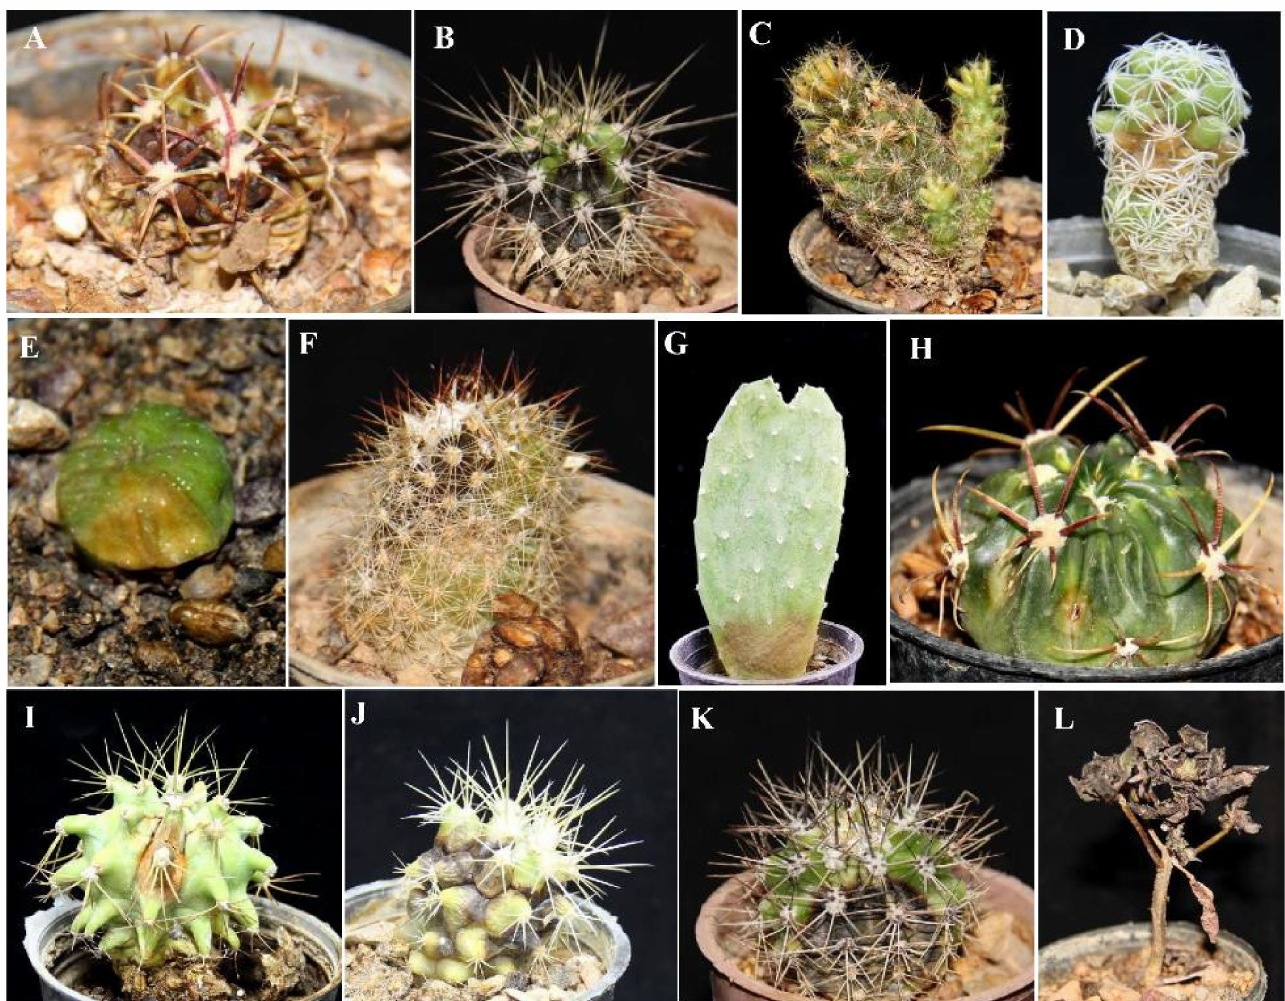
Figure 4. Symptoms induced by artificial inoculation of Neocosmospora falciformis on various succulent plants. ( A ) Crown rot on Ferocactus macrodiscus ; ( B ) root and crown rot on Mammillaria bernalensis ; ( C ) brown rot on Mammillaria prolifera ; ( D ) root and crown rot on Mammillaria gracilis ; ( E ) root and stem rot on Astrophytum asterias ; ( F ) rotting, yellowing, and black spots on Mammillaria spinosissima ; ( G ) crown rot on Opuntia ficus-indica ; ( H ) chlorosis on Ferocactus macrodiscus ; ( I ) chlorosis on Ferocac- tus glaucescens ; ( J ) black spots on Echinocactus grusonii ; ( K ) necrosis and black spots on the crown of Mammillaria bernalensis ; and ( L ) root and crown rot on Aeonium arboreum